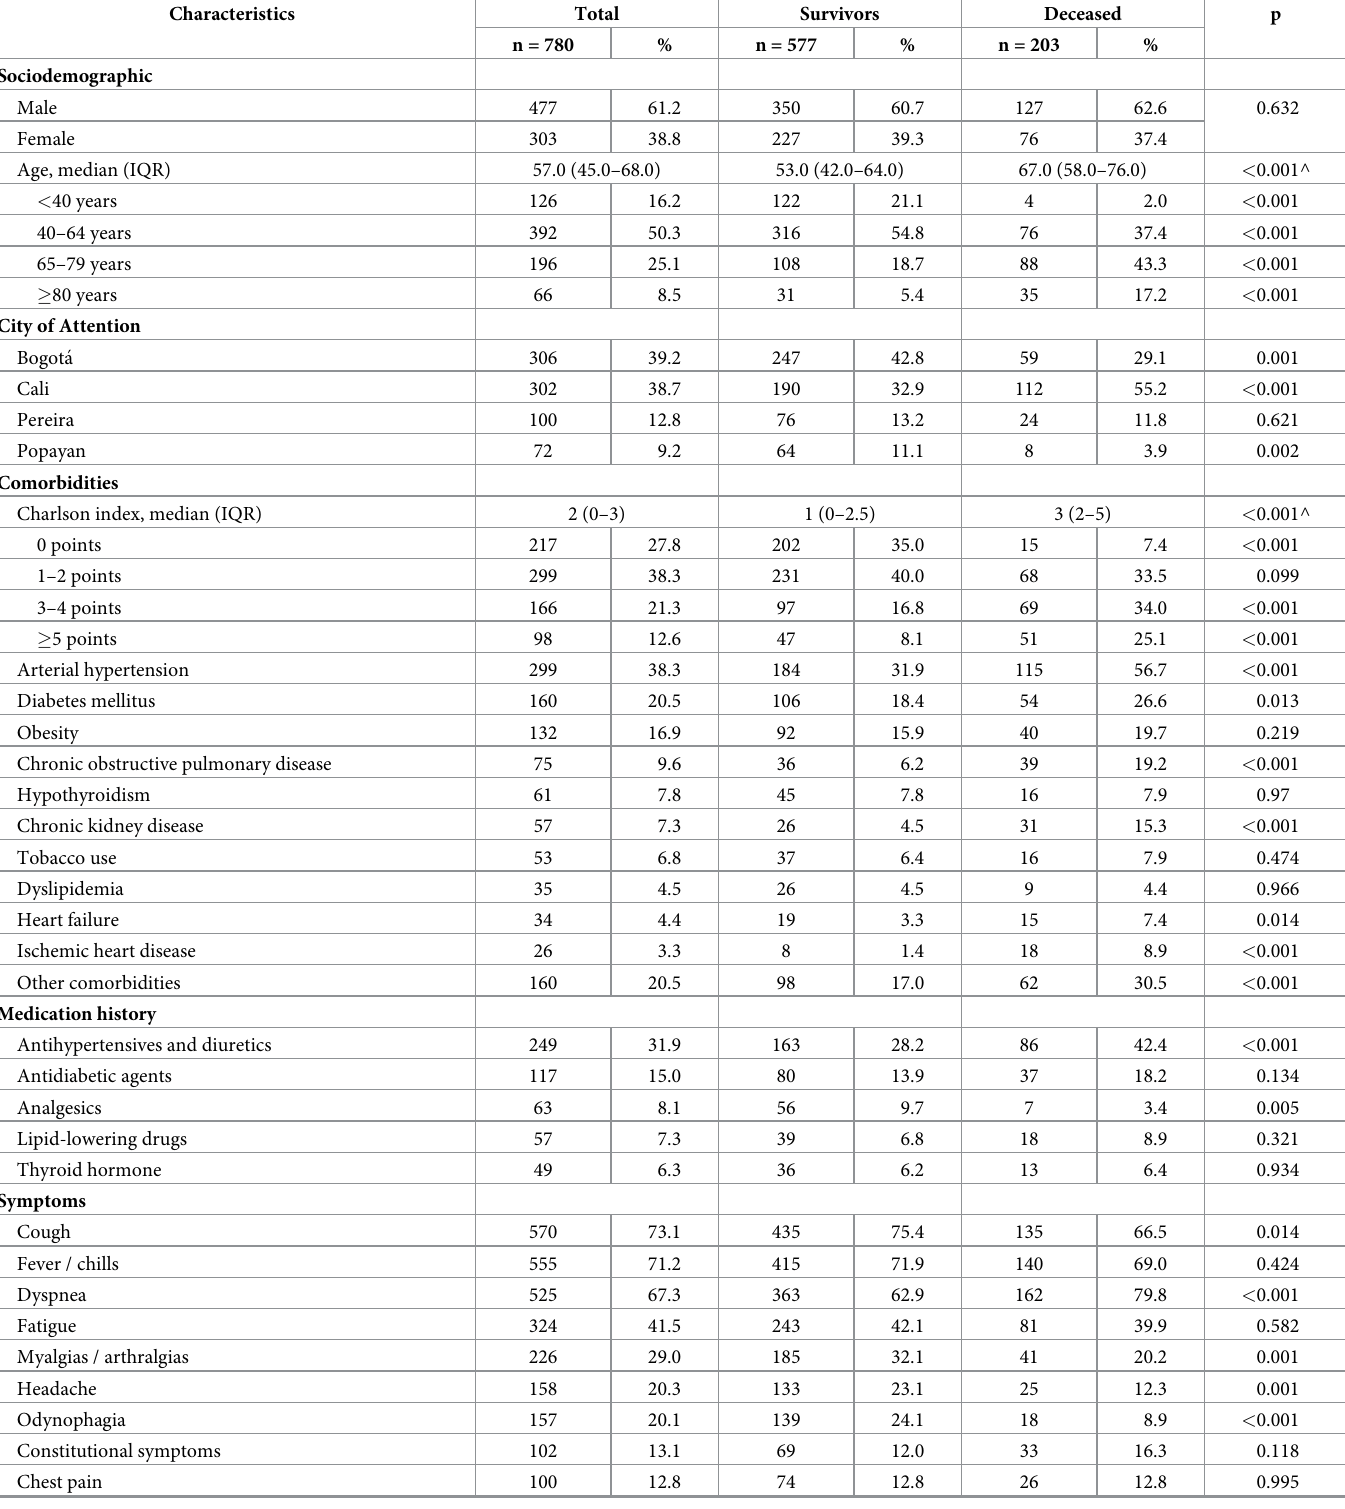
Table 1. Sociodemographic, pharmacological, clinical and comorbidity variables among patients who survived and died, infected by SARS-CoV-2.